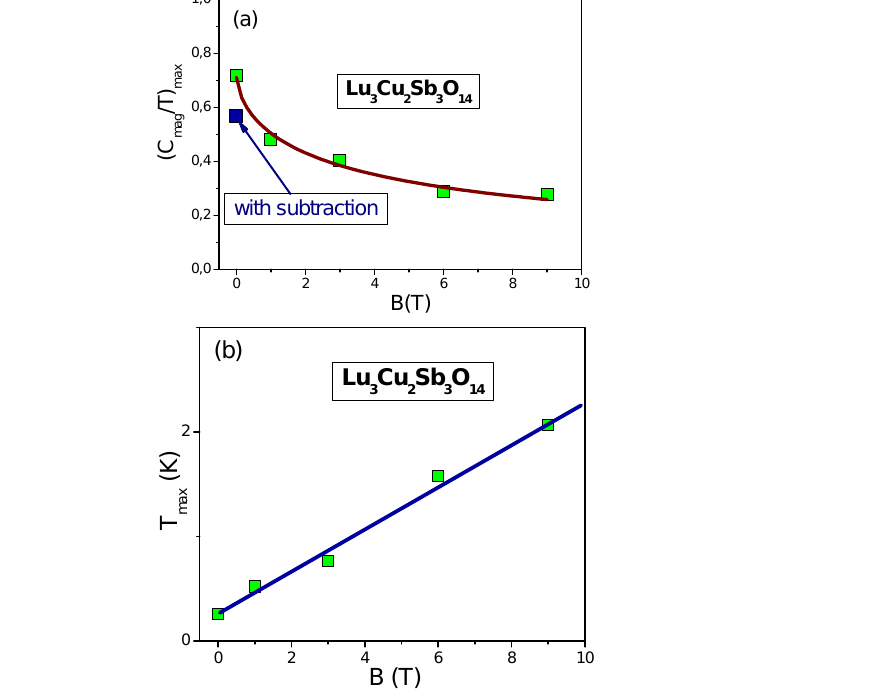
Figure 5. The properties of the specific heat. ( a ) The maximum values of ( C mag / T ) max of the specific heat C mag / T versus magnetic field B are shown by the solid squares, see the inset, Figure 1. The solid FIG. 5: The properties of the specific heat. (a) The maximum curve is approximated by M ∗ max ( B ) ∝ B − 2/3 in accordance with Equation (5). The arrow depicts the values of ( C mag /T ) max of the specific heat C mag /T versus magnetic field B are shown by the solid squares, see the inset, FIG. 5: The properties of the specific heat. (a) The maximum position of ( C mag / T ) max at B = 0 when the impurity Schottky contribution is subtracted [23]. ( b ) The Fig. 1. The solid curve is approximated by M ∗ max ( B ) B − 2 / 3 values of ( C mag /T ) max of the specific heat C mag /T versus ∝ temperature T max ( B ) , at which the maxima of ( C mag / T ) are located, see Figure 1. The solid straight in accordance with Eq. (5). The arrow depicts the position magnetic field B are shown by the solid squares, see the inset, of ( C mag /T ) max at B = 0 when the impurity Schottky contri- Fig. 1. The solid curve is approximated by M ∗ max ( B ) B − 2 / 3 line traces the function T max ∝ B , see Equation ∝ in accordance with Eq. (5). The arrow depicts the position bution is subtracted [23]. (b) The temperature T max ( B ), at of ( C mag /T ) max at B = 0 when the impurity Schottky contri- which the maxima of ( C mag /T ) are located, see Fig. 3 (a). bution is subtracted [23]. (b) The temperature T max ( B ), at The solid straight line traces the function T max B , see Eq. ∝ which the maxima of ( C mag /T ) are located, see Fig. 3 (a). (7). The solid straight line traces the function T max B , see Eq. ∝ (7). between the theory (solid curve) and the experiment is good. At B = 0 the arrow shows the position of the maxi- between the theory (solid curve) and the experiment is mum with the subtracted impurity Schottky contribution good. At B = 0 the arrow shows the position of the maxi- [23]. We believe that there is no reason to subtract the mum with the subtracted impurity Schottky contribution the impurity Schottky contribution, since it is not possi- [23]. We believe that there is no reason to subtract the ble to differentiate the contribution from the impurities the impurity Schottky contribution, since it is not possi- and from those coming from the pure crystal holding SC- ble to differentiate the contribution from the impurities QSL [45], since both of them form the integral SCQSL and from those coming from the pure crystal holding SC- [14]. The solid line in Fig. 5 (b) represents function QSL [45], since both of them form the integral SCQSL [14]. The solid line in Fig. 5 (b) represents function